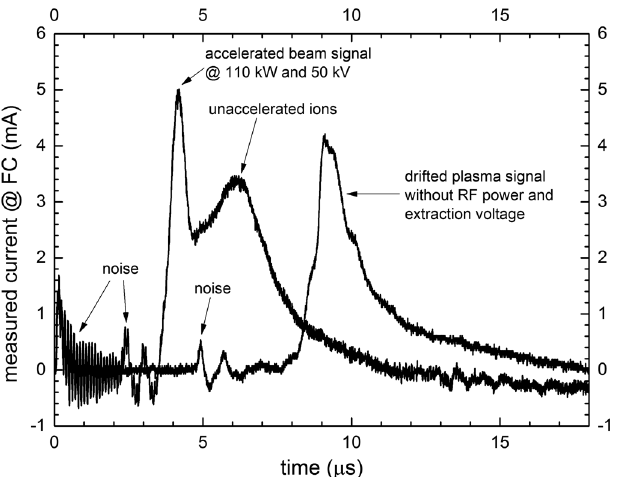
FIG. 17. Detected energy channels measured by the Canberra SSD. The 5.486 MeV channel is the calibration source. The detected signal was calculated as 25.71